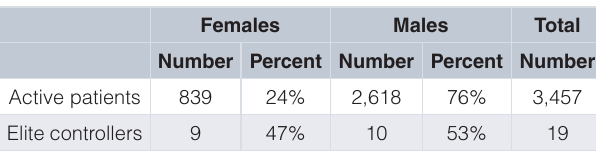
Table 1. 1917 clinic demographics, female versus male elite